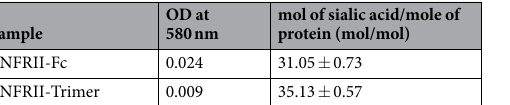
To determine whether TNFRII-Trimer was properly glycosylated, the resorcinol method was applied to detect sialic acid (SA) content of TNFRII-Trimer with TNFRII-Fc as a control. The SA content values for TNFRII-Trimer and TNFRII-Fc were determined to be 35.13 and 31.05 mol of sialic acid/mol of protein, respectively (Table 1), indicating heavy glycosylation in both fusion proteins. Neutralization of TNF- α -induced cytotoxicity by TNFRII-Trimer. To determine if TNFRII-Trimer is a potent inhibitor of the trimeric TNF- α , an in vitro TNF- α bioassay was carried out using a TNF- α sensitive cell line L929 17 . The result shown in Fig. 4a indicated that TNFRII-Trimer had higher activities than that of TNFRII-Fc in inhibiting the TNF- α mediated apoptosis. The IC 50 values for TNFRII-Trimer and TNFRII-Fc based weight basis were 8.5 and 10.1 ng/mL, respectively, according to the dose-response cell index curve (Fig. 4a). Based on theoretical molecular weight of the two native TNFRII fusion proteins, the TNFRII-Trimer with each subunit having a molecular weight of 52.5 kDa is at lease 1/3 larger than the dimeric TNFRII-Fc with each subunit being 51.2 kDa in molecular weight (Fig. 2c,d). Therefore, based on molar ratio, the neutralization activities of trimeric TNFRII-Trimer was about 2-fold higher than that of the dimeric TNFRII-Fc with IC 50 being 54.0pM and 98.6pM, respectively. Furthermore, the much steeper S-curve in concentration dependent TNF- α neutralization for TNFRII-Trimer observed in comparison with TNFRII-Fc (Fig. 4a) was also indicative of tighter and cooperative binding of each subunit of TNFRII-Trimer to the ligand. Kinetic analysis of TNFRII-Trimer binding to human TNF- α . employed. Biotin-labeled TNFRII-fusion proteins were first captured on Streptavidin (SA) sensors, and real-time binding curves were obtained by exposing the biosensor to gradient concentrations of TNF- α . As expected, TNFRII-Trimer exhibited higher ligand binding affinities than that of TNFRII-Fc with KD being 7.39 × 10 − 11 M vs. 23.1 × 10 − 11 M, respectively. The binding kinetics parameters were listed in Table 2. While TNFRII-Fc